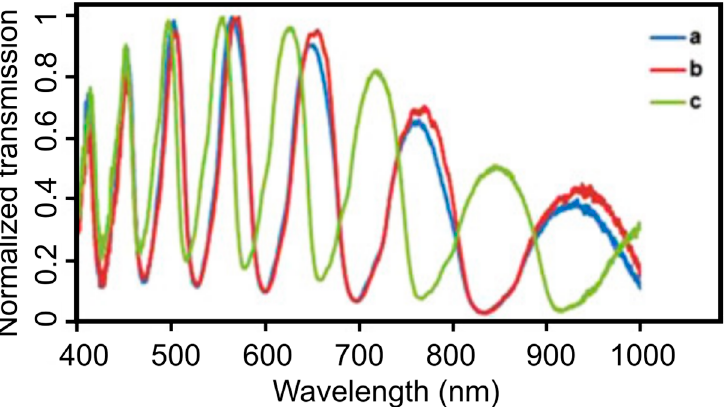
Figure 10. Transmission spectra measurements of functionalized MOFs. ( a ) Unmodified MOF. ( b ) MOF sample treated with a concentrated H 2 SO 4 solution and ( c ) in a mixture of H 2 SO 4 and H 2 O 2 (50:50 volume ratio). Reproduced with permission from [60].